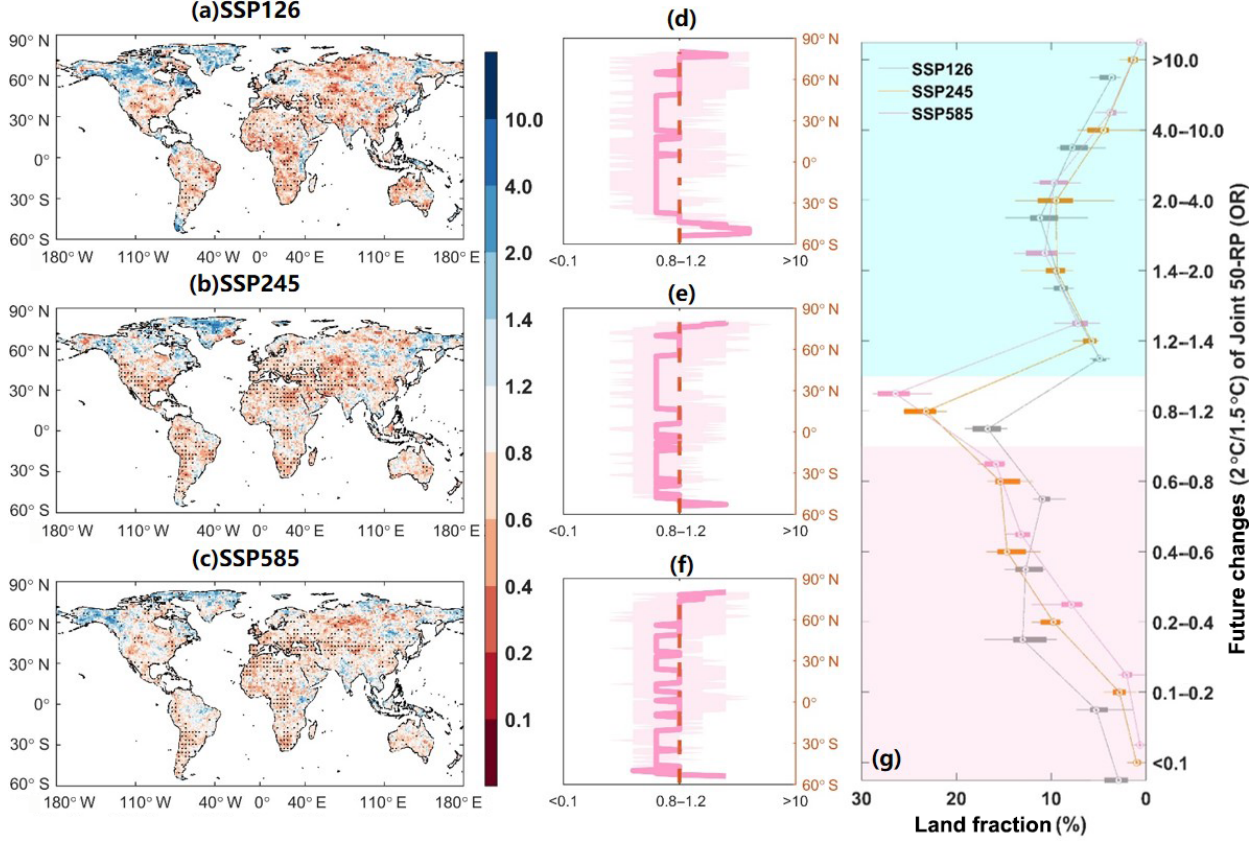
Figure 8. Projected changes in joint 50-year return periods of droughts between the 1.5 and 2.0 ◦ C warming